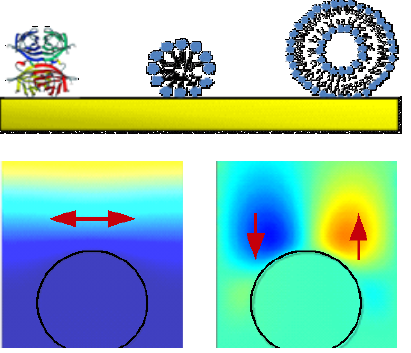
Figure 29. Top: Typical objects to be modeled numerically are adsorbed particles of various kinds (proteins, micelles, vesicles, not drawn to scale). Bottom: Results from a finite element method (FEM) simulation in 2D. Left: tangential velocity. Right: normal velocity. The truncated cylinder is rigid. The simulation outputs the periodic stress at the resonator surface (not shown), which can be converted to Δ with Equation (25).